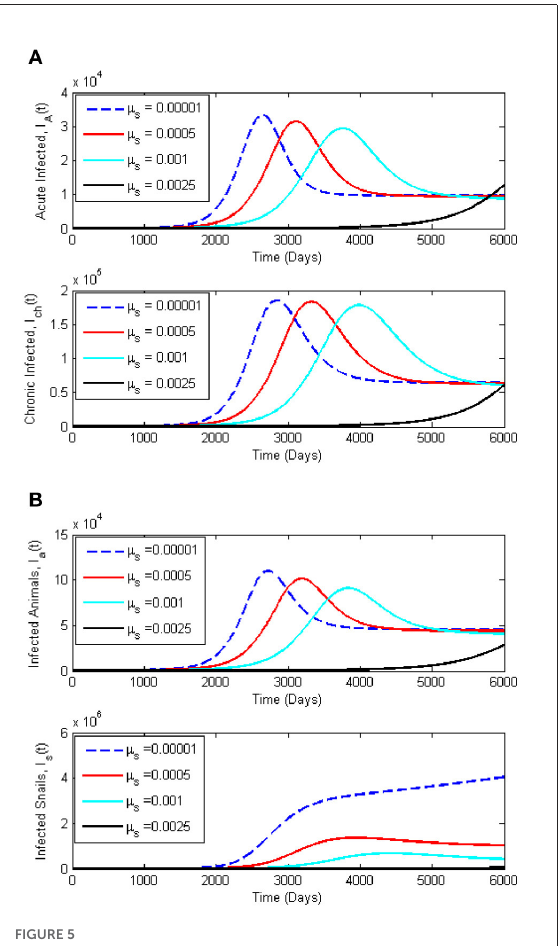
FIGURE5 (A) Dynamics of Schistosomiasis infection among the infected human classes, I a ( t ) and I ch ( t ) for varying snail death rate, µ s . (B) Dynamics of Schistosomiasis infection among the infected classes, I a ( t ) and I s ( t ) for varying snail death rate, µ s . All other parameters for this simulation are given in Table